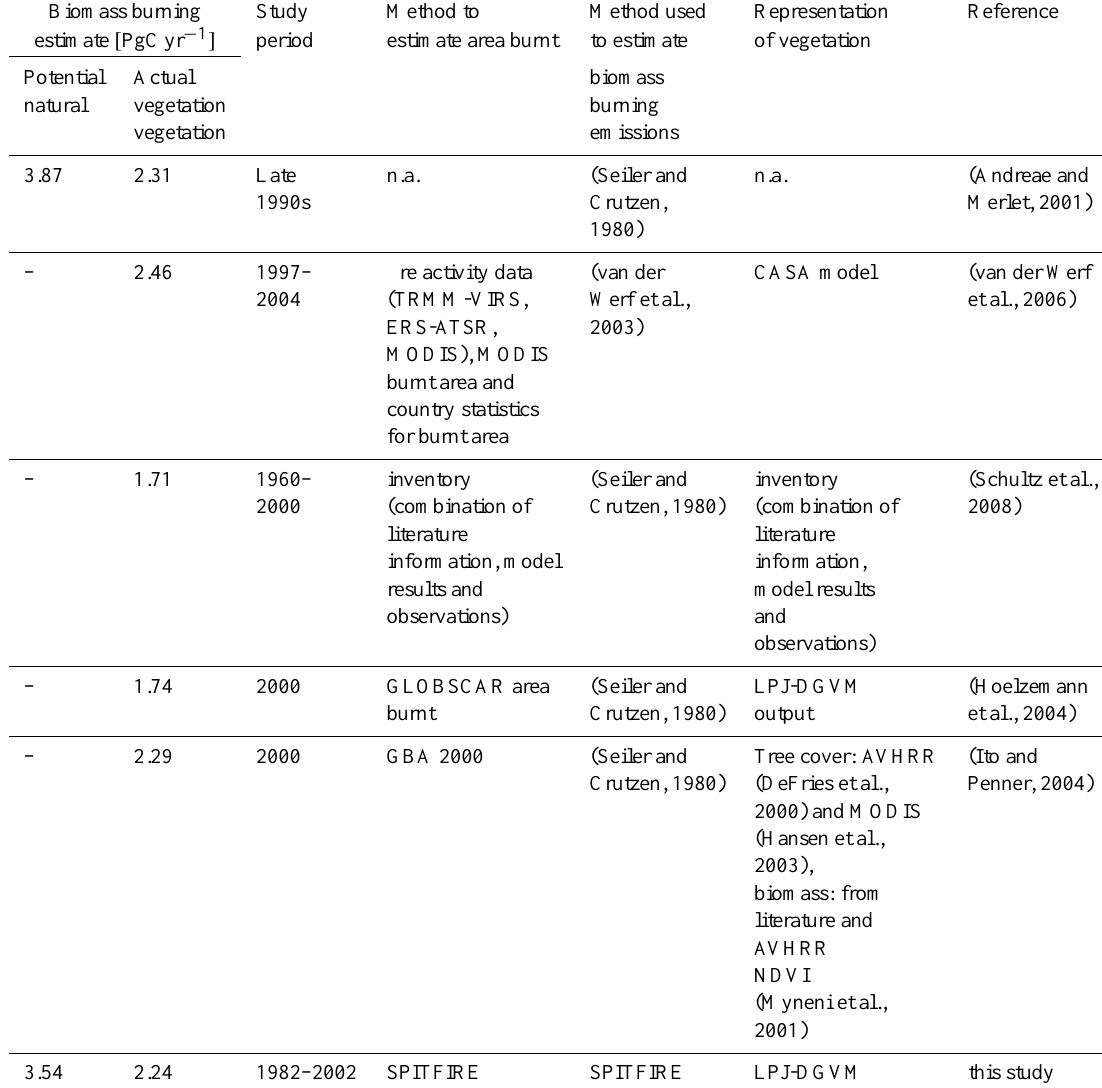
Table 2. Comparison of estimates of global annual CO 2 release [PgCyr − 1 ]. Biomass burning Study Method to Method used Representation Reference estimate [ PgCyr − 1